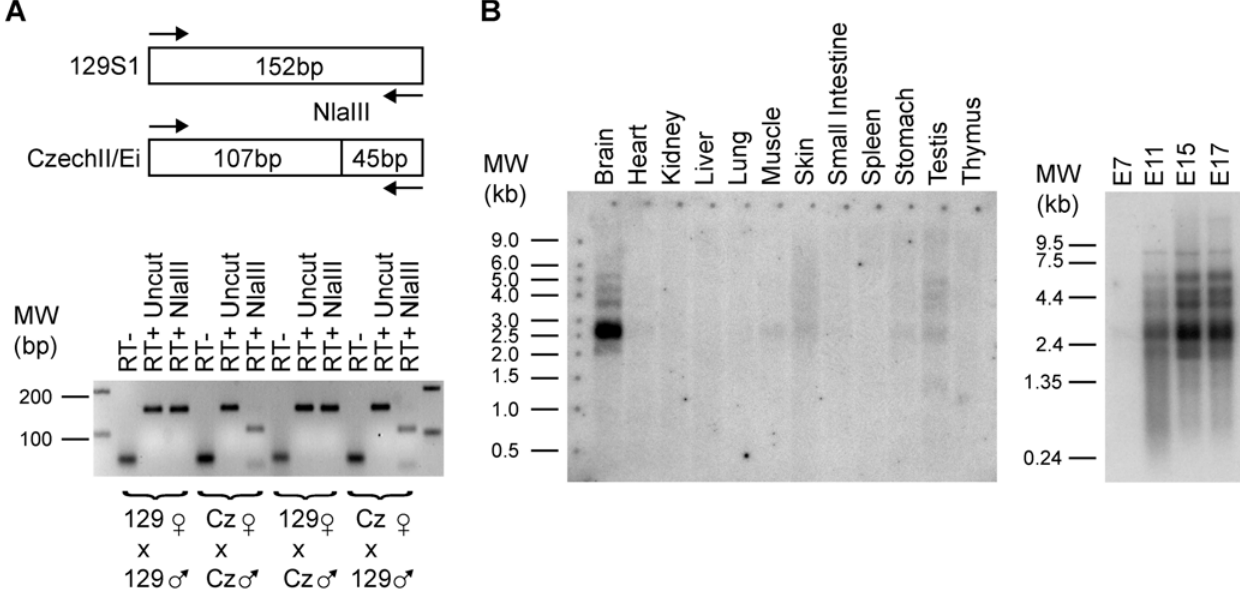
Figure 7. Irm is maternally expressed, alternatively spliced, and abundant in the adult brain. (A). A single nucleotide polymorphism in Irm cDNA was identified at 1094A R T between 129S1 and CzechII/Ei mouse strains that creates a NlaIII restriction site in the CzechII/Ei Irm cDNA. RT-PCR was performed with Irm primers 988Up and 1140Dn. Restriction digests of RT-PCR products from intraspecific crosses between these two subspecies by NlaIII demonstrated that Irm is expressed in a monoallelic manner from the maternal allele. (B) An adult tissue (left) and total embryo from different gestational days (right) polyA + RNA blot (left) was hybridized with a Irm/Rian exon 1 cDNA probe. A 2.5 kb transcript was predominantly detected in the brain and to a significantly lesser extent in testis, stomach, and muscle. Higher molecular weight bands of lower relative abundance in comparison to the 2.5 kb message were also seen that reflect the heterogeneity in spliced variants. Since Rian RNA is approximately 5.4 kb, the predominant RNA product from the Irm/Rian promoter is Irm RNA, while Rian accounts for at most 5% of total transcripts. This result is consistent with the relative abundance of ESTs that are specific for each of the alternatively spliced products.